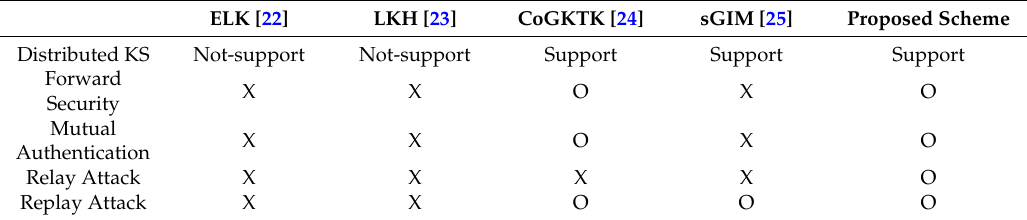
Table 3. Comparative performance analysis between sensor